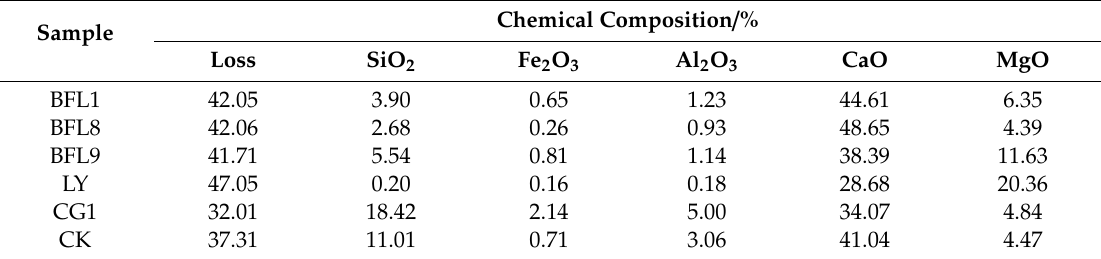
Table 1. Chemical composition of rocks